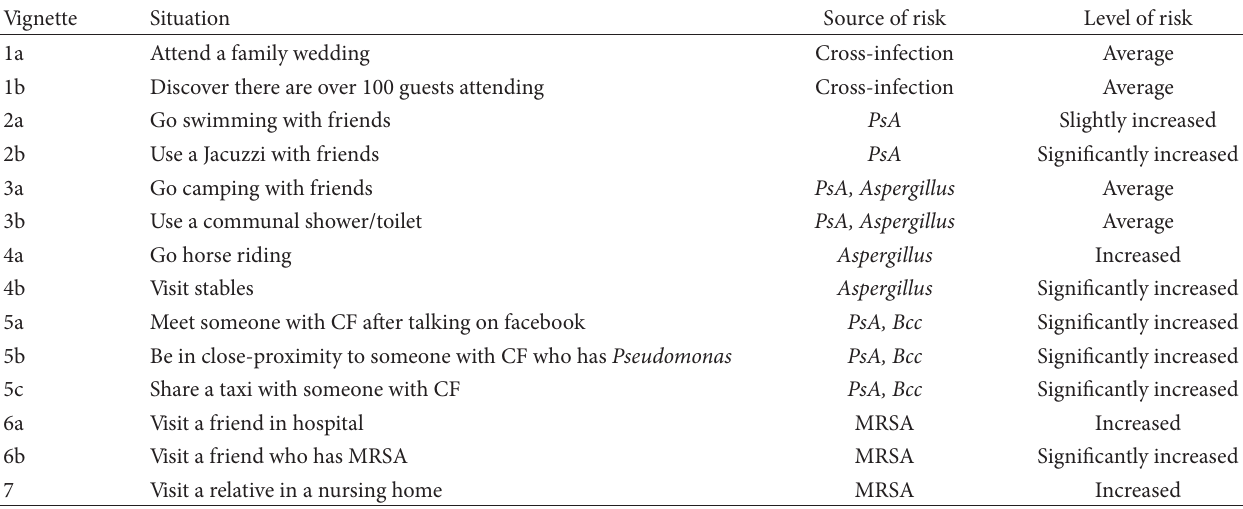
T 1: Description of vignettes and source and level of